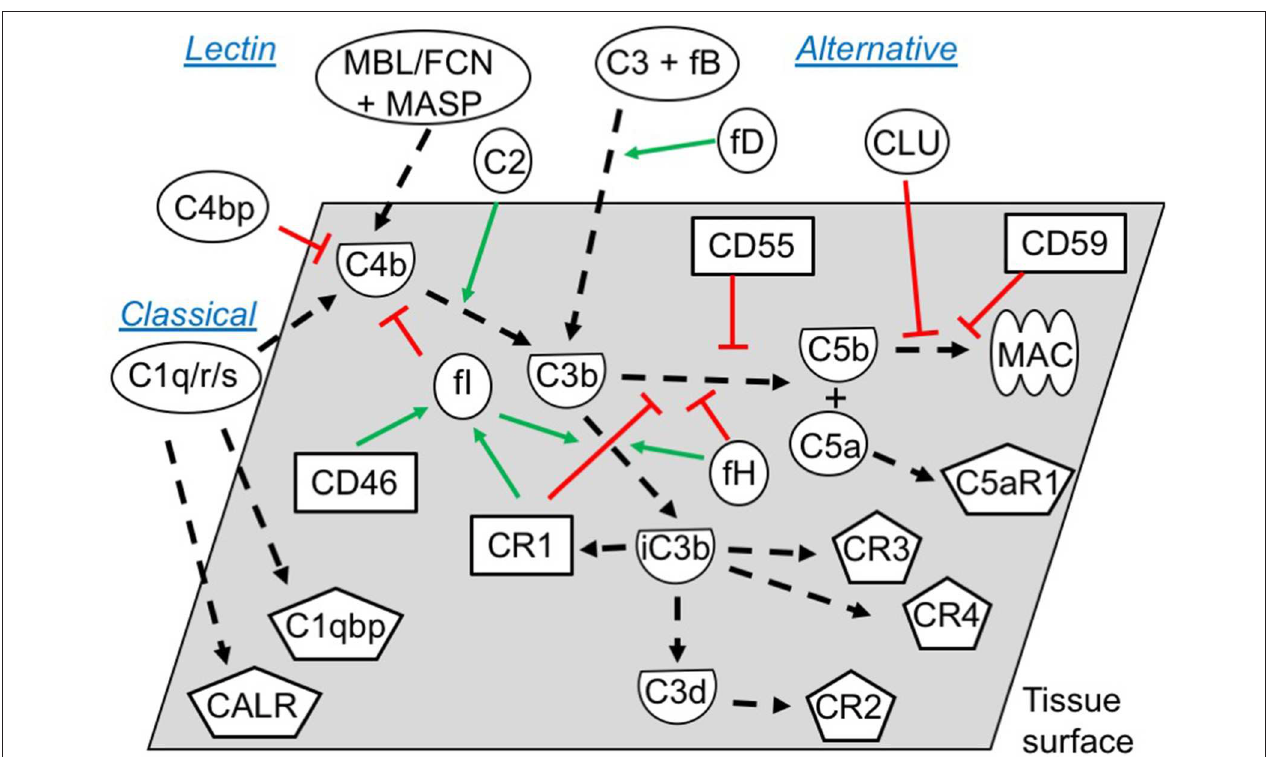
FIGURE 5 | Functional overview of the embryonic complement system. Indicated are the canonical functional roles of membrane-expressed complement regulators (squares), soluble complement components (circles), and their cleaved activated membrane-deposited forms (demi-circles). Finally, embryonically expressed complement receptors are shown (pentagons). All molecules depicted were found to be expressed or bound by the embryos in this study (exceptions: C4, mannose binding lectin (MBL), ficolins (FCNs), and some MAC-components). The classical and the lectin pathways are initiated by target-binding of pattern recognition molecules such as C1q, or MBL and FCNs, respectively. Utilizing their associated proteases C1r/s or MASPs, they activate C4 and C2, which subsequently activate C3. Alternative pathway activation of C3 occurs when factor D cleaves C3-associated factor B, which generates a novel C3-cleaving enzyme; C3bBb. Cleavage of C3 by either pathway leads to generation of soluble C3a and surface-deposited C3b, which amplifies alternative pathway C3 activation, and subsequently activates C5 to C5a and C5b. Finally, C5b initiates the assembly of the pore-forming MAC ( 1, 36). To avoid excessive immunological targeting of self, human cells express or recruit inhibitors of complement activation. Membrane regulators may function; (1) by disrupting the enzymes cleaving C3 and C5 (CR1, CD55), (2) as co-factors for factor I-mediated degradation of C3b and C4b (CR1, CD46), or (3) by inhibiting MAC-formation directly (CD59). Soluble regulators such as factor H and C4bp inhibit activation by mechanisms 1 and 2, while clusterin work through mechanism 3. Inactivation of C3b, leads to generation of iC3b, C3dg, and finally C3d. While C3b and iC3b function as opsonins for increased phagocytosis by antigen presenting cells (through CR3 and CR4), C3d has important biological functions as an important internal adjuvant aiding antigen uptake by dendritic cells and inducing efficient antibody responses in B cells (through CR2) (1, 36, 37). While CR2, CR3 and CR4 expression is mainly described on immune cells, our study found embryonic expression of these receptors, along with the signaling receptors for C1q; calreticulin (CALR) and